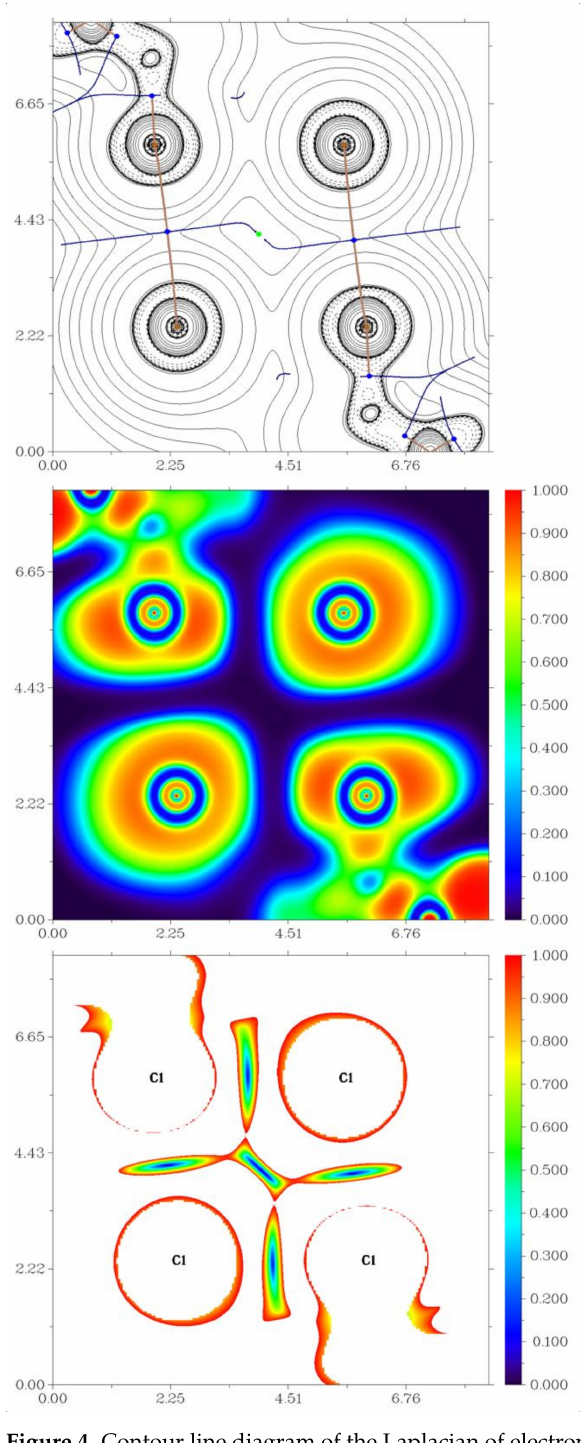
Figure 4. Contour line diagram of the Laplacian of electron density distribution ∇ 2 ρ ( r ), bond paths, and selected zero-flux surfaces (top panel), visualization of electron localization function (ELF, center panel), and reduced density gradient (RDG, bottom panel) analyses for intermolecular non-covalent interactions Cl ··· Cl in 1 . Bond critical points (3, − 1) are shown in blue, nuclear critical points (3, − 3)— in pale brown, cage critical points (3, +3)—in light green, bond paths are shown as pale brown lines, length units—Å, and the color scale for the ELF and RDG maps are presented in